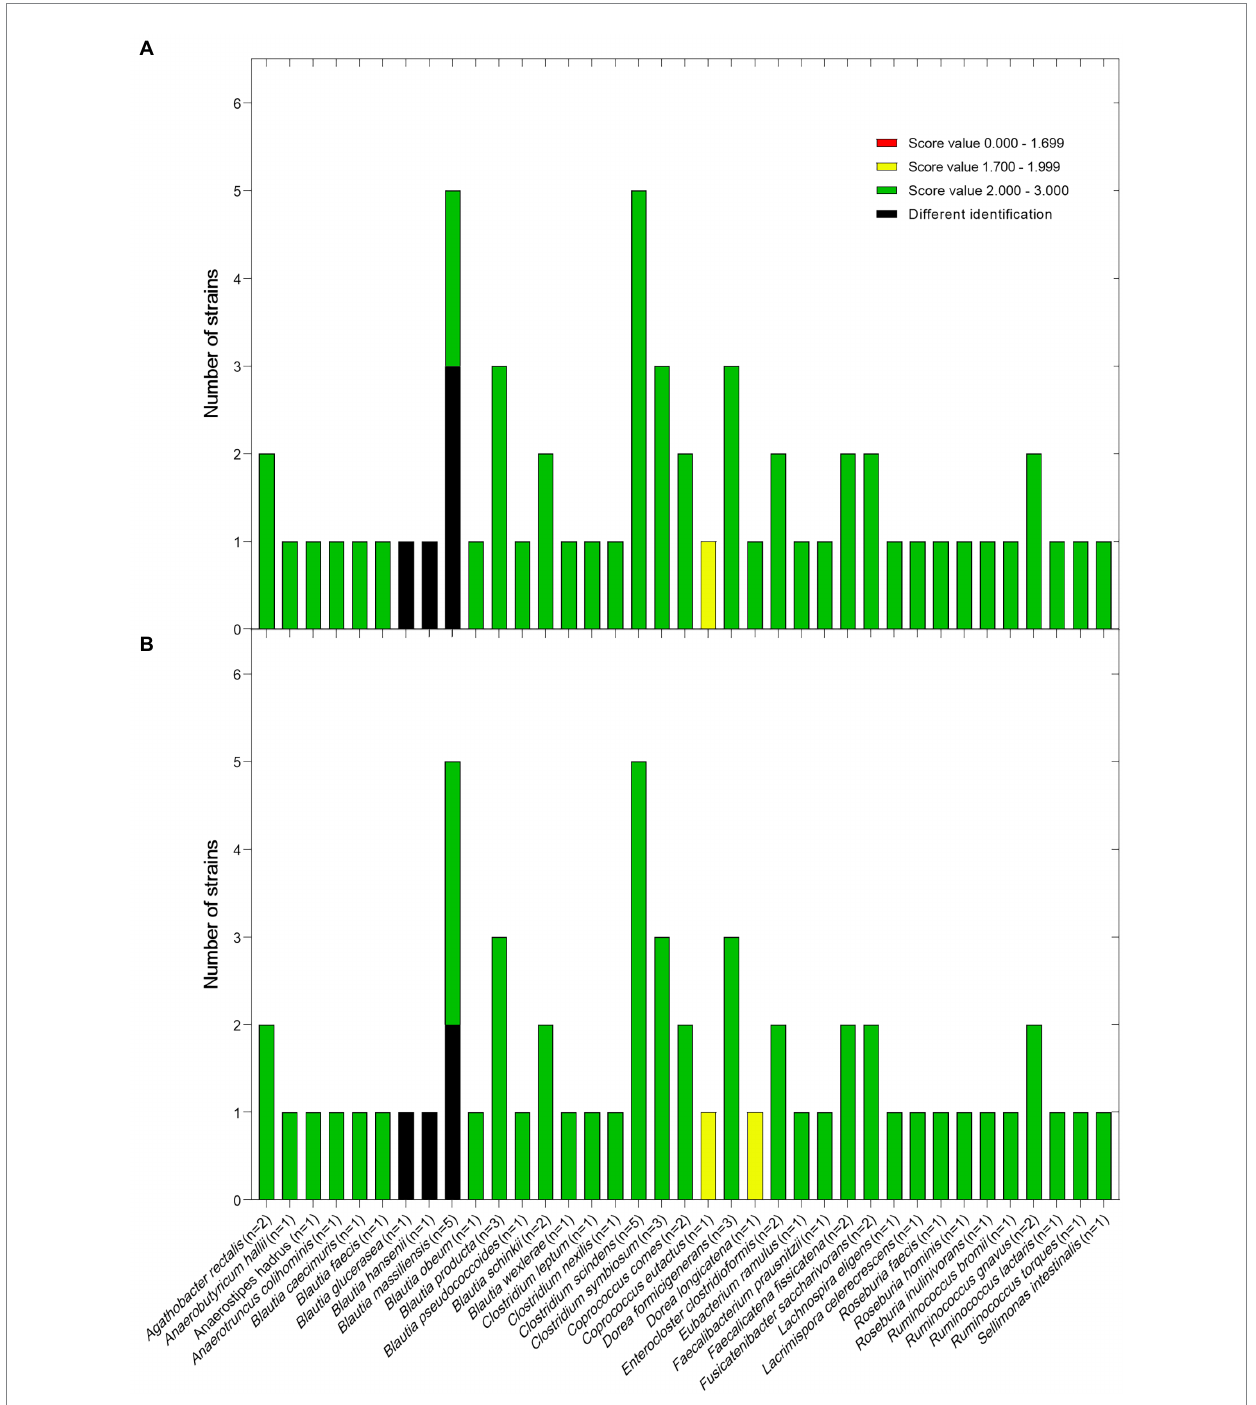
FIGURE 2 Blind test of Clostridia strains using the newly created CLOSTRI-TOF MS performed in lab A (A) and lab B (B) . The highest matching scores of the spectra were represented by ranges indicating high confidence identification (2.000–3.000), low confidence identification (1.700–1.999) and no organism identification possible